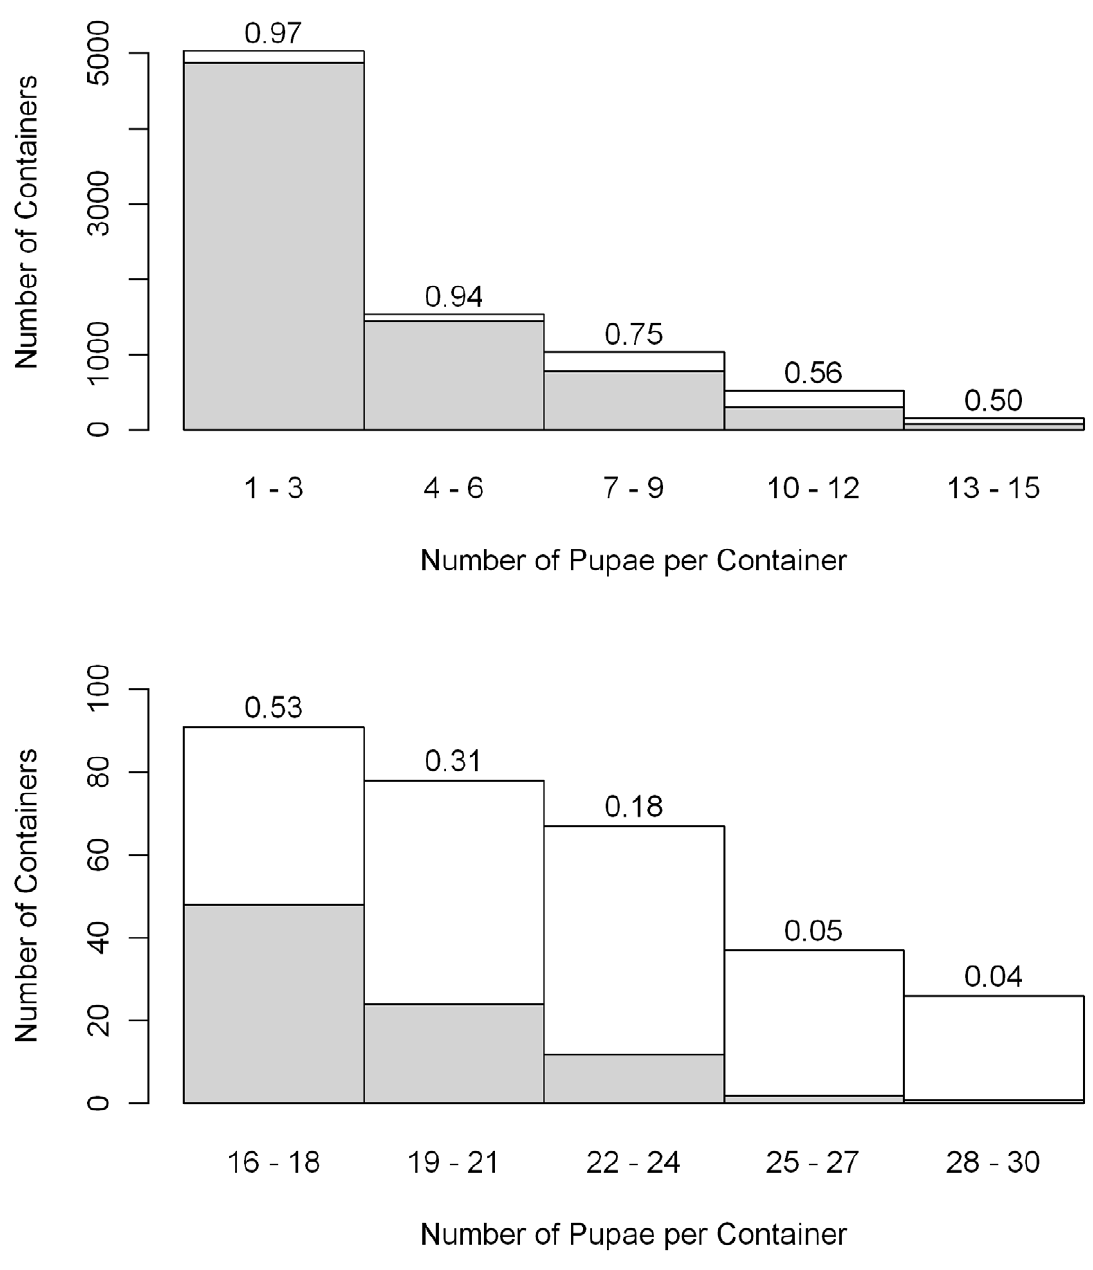
Figure 3. Container level model fit. The height of each bar indicates the total number of containers with observed pupae counts in each abundance category. The gray portion indicates the number of containers that the observed count of Ae. aegypti pupae fall between the 2.5 and 97.5 percentile of realizations generated using the estimated model and the proportions are given above each bar. The height of the white bars indicates the number of containers with pupal counts above the 95% simulation envelope.